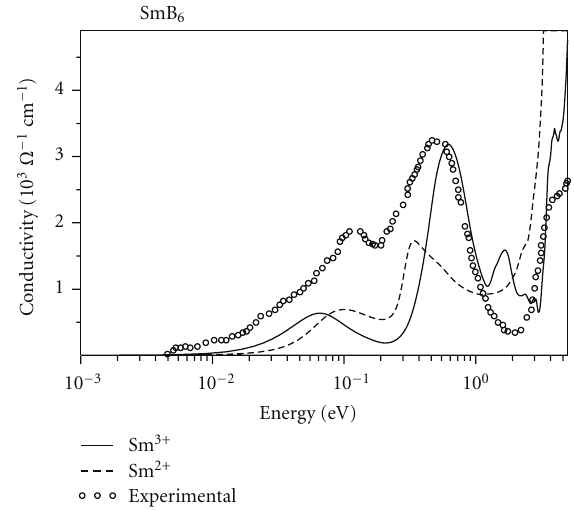
Figure 55: Calculated diagonal part of the optical conductivity σ 1 xx ( ω ) of SmB 6 in the LSDA+ U approximation [349] compared with the experimental measurements at 13K (open circles)